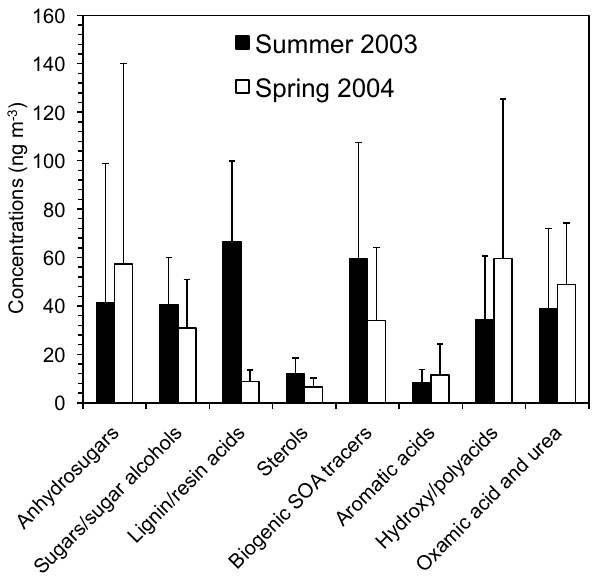
Fig. 3. Total concentrations of organic compound classes de- tected during two aircraft campaigns. Anhydrosugars, aromatic acids, hydroxy/polyacids and oxamic acid and urea were lower in summer than in spring, while sugars/sugar alcohols, lignin/resin acids, sterols and biogenic secondary organic aerosol (SOA) trac- ers showed higher levels in summer than in spring.